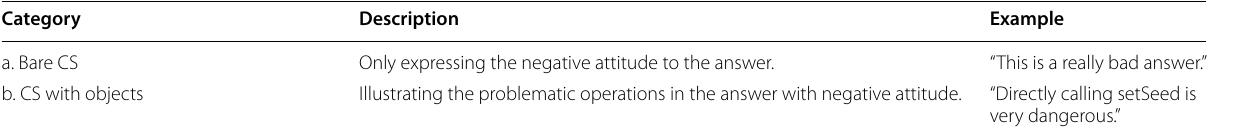
Table 1 Category of controversial